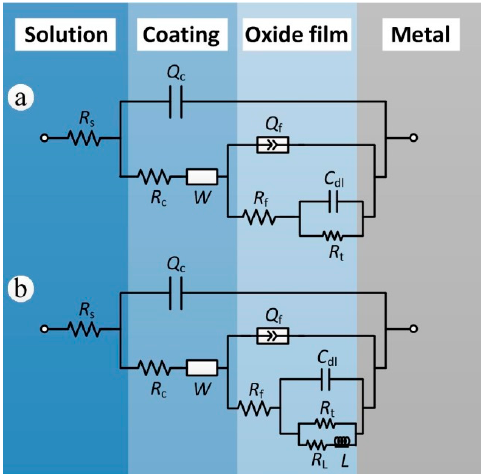
Figure 9. Electrochemical equivalent circuits for fitting the impedance data: ( a ) 7 and 12 years; ( b ) 20 years.